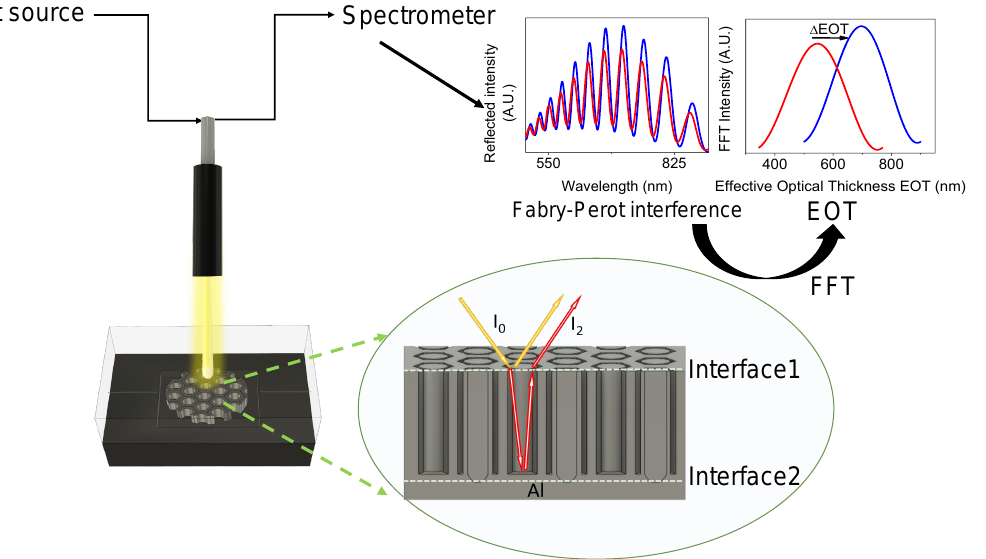
Figure 2. Schematic of the reflectance interferometric spectroscopy and flow cell